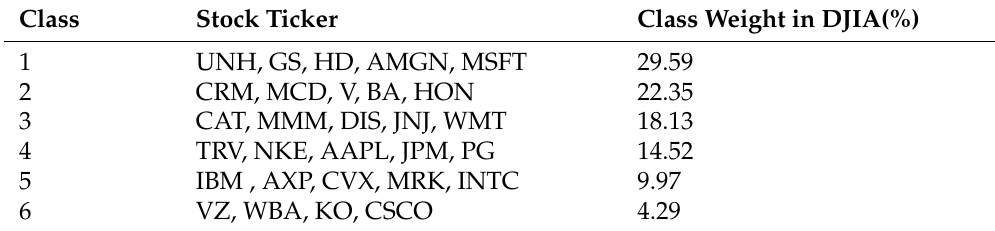
Table 1. Breakdown of the asset classes in the test